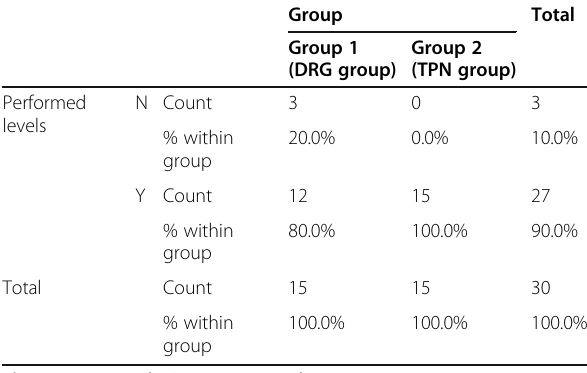
Table 3 Performed levels